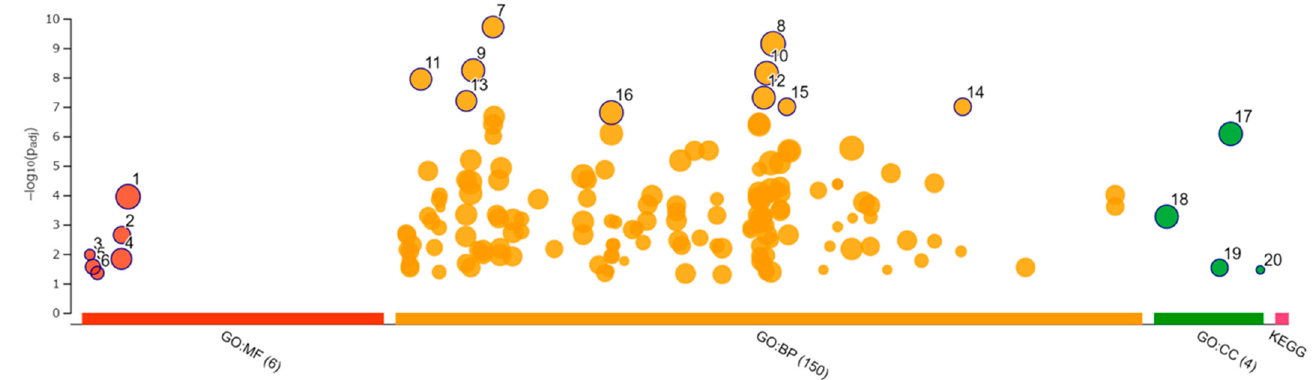
Figure 9. Functional enrichment analysis of 229 downregulated differentially expressed genes by g:Profiler. Results of enrichment analysis presented in the form of a Manhattan plot, where the x -axis shows the functional terms grouped by the color-coded source database, while the y -axis shows the enrichment adjusted p -values in negative decimal logarithm scale. Dots in the graph indicate all enriched terms meeting the significance criterion of p < 0.05. Table 4. Top 10 of each gene ontology (GO) molecular function (MF), biological processes (BP), and cellular component (CC) and KEGG terms.